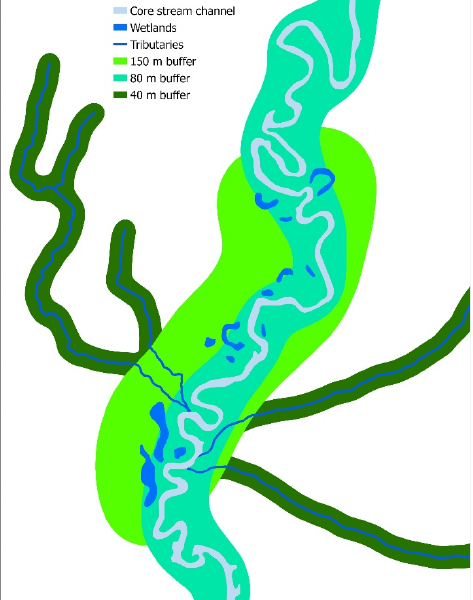
Figure 3. A variation of the Spaghetti-meatball buffer-zone delineation with variable buffer widths as recommended by Olson et al. [35,89] applied to the mainstem river corridor, including the tributaries to the mainstem.